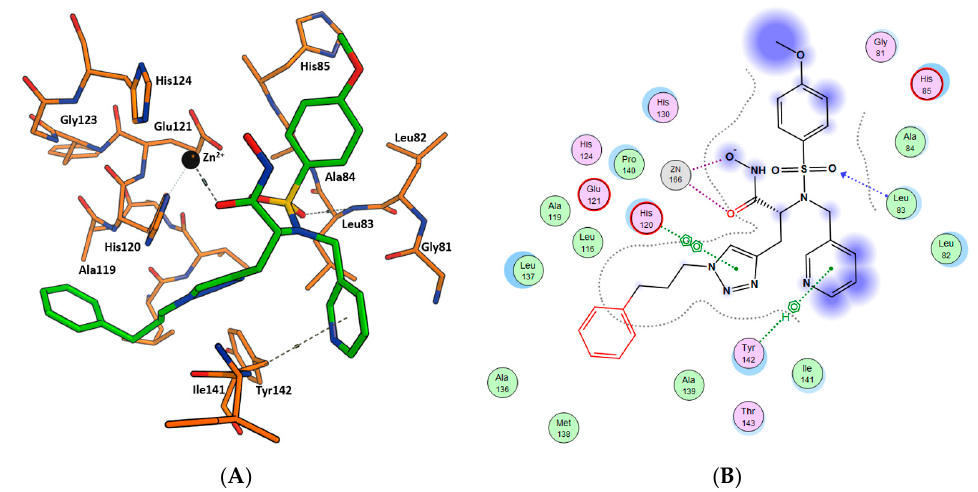
Figure 4. ( A ) Modeled complex of 1,4-triazole 21 bound at the MMP-2 active site (PDB accession code: 1HOV). ( B ) Ligand interaction map of 21 generated using MOE. Regions surrounded by a blue cloud indicate solvent-exposed portions of the ligand.